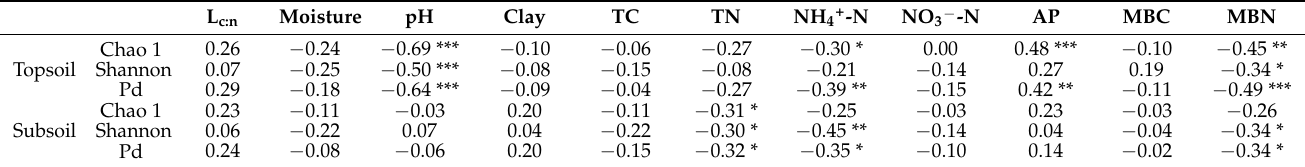
Table 2. Correlations between fungal diversity indices and litter and edaphic properties in topsoil and subsoil.